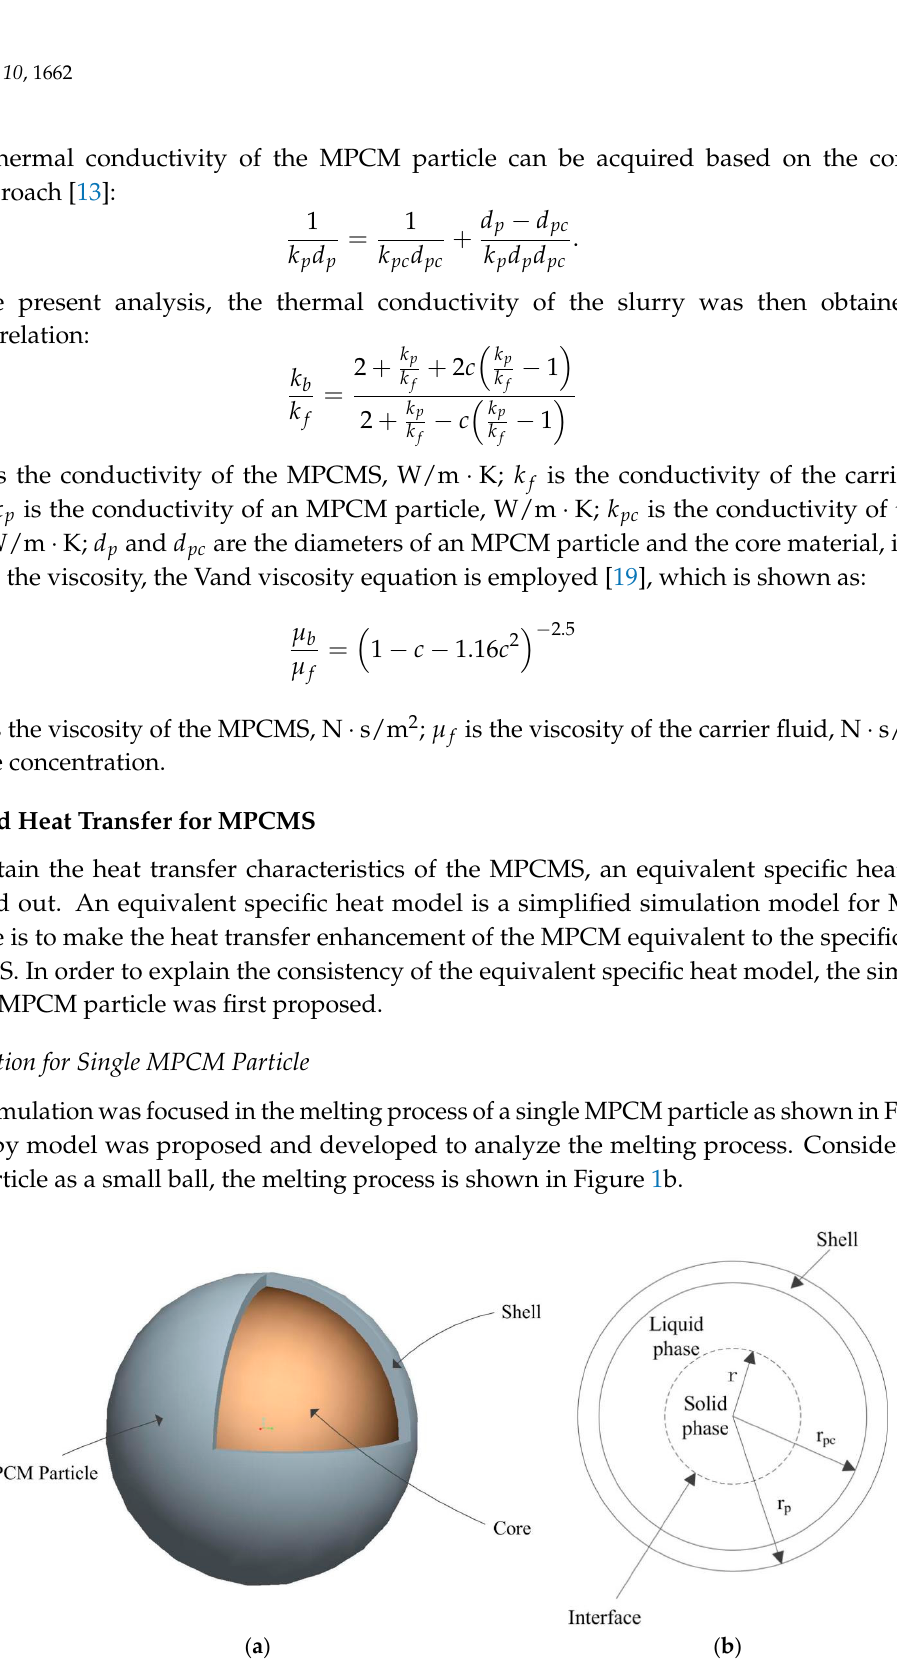
Figure 1. Schematic of a single microencapsulated phase change material (MPCM) particle melting process. ( a ) An MPCM particle structure. ( b ) The phase change inside an MPCM particle.